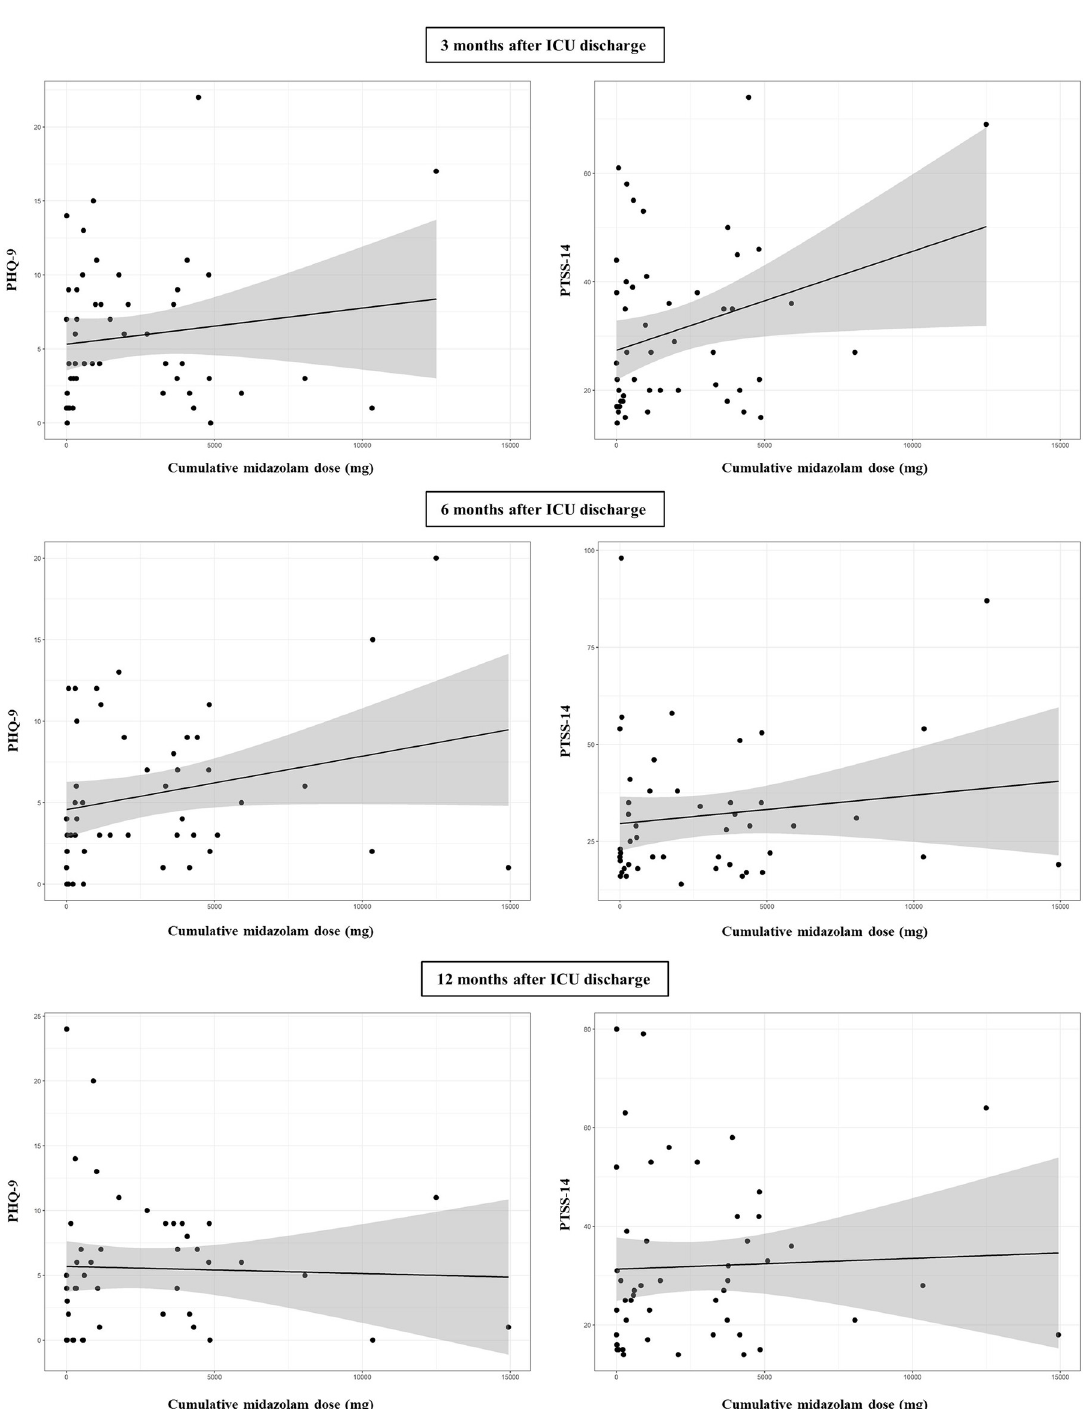
Fig 3. Relationship between cumulative dose of midazolam and psychiatric symptoms in ARDS survivors 3, 6 and 12 months after ICU discharge.